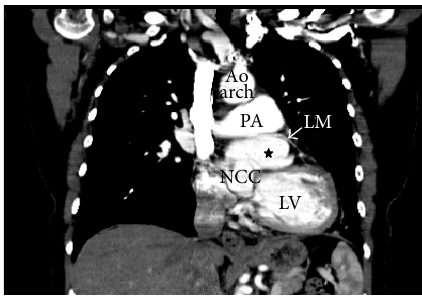
Figure 2: Coronal section of the chest CT shows markedly enlarged left sinus of Valsalva (asterisk). Also note that the course of the left main (LM) coronary artery is displaced superiorly and passing through the dilated sinus of Valsalva and main pulmonary artery (PA). NCC: noncoronary cups, LV: left ventricle, and Ao arch: aortic arch.